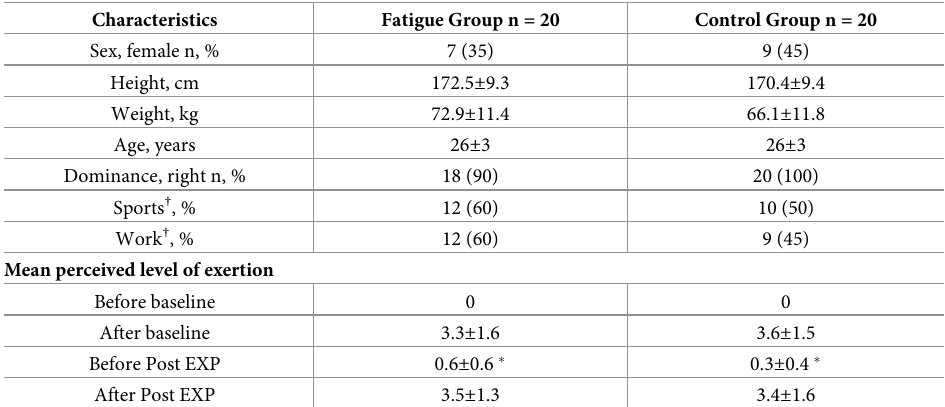
Table 1. Participant’s baseline